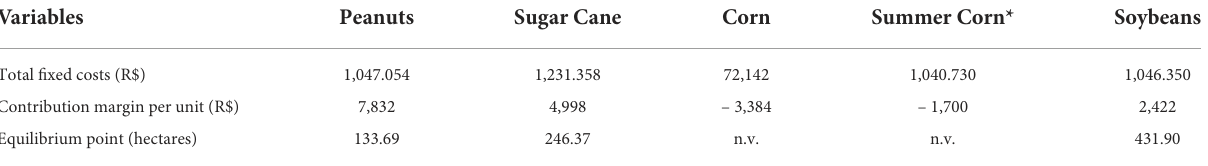
TABLE 6 Equilibrium points in hectares for the crops under study.